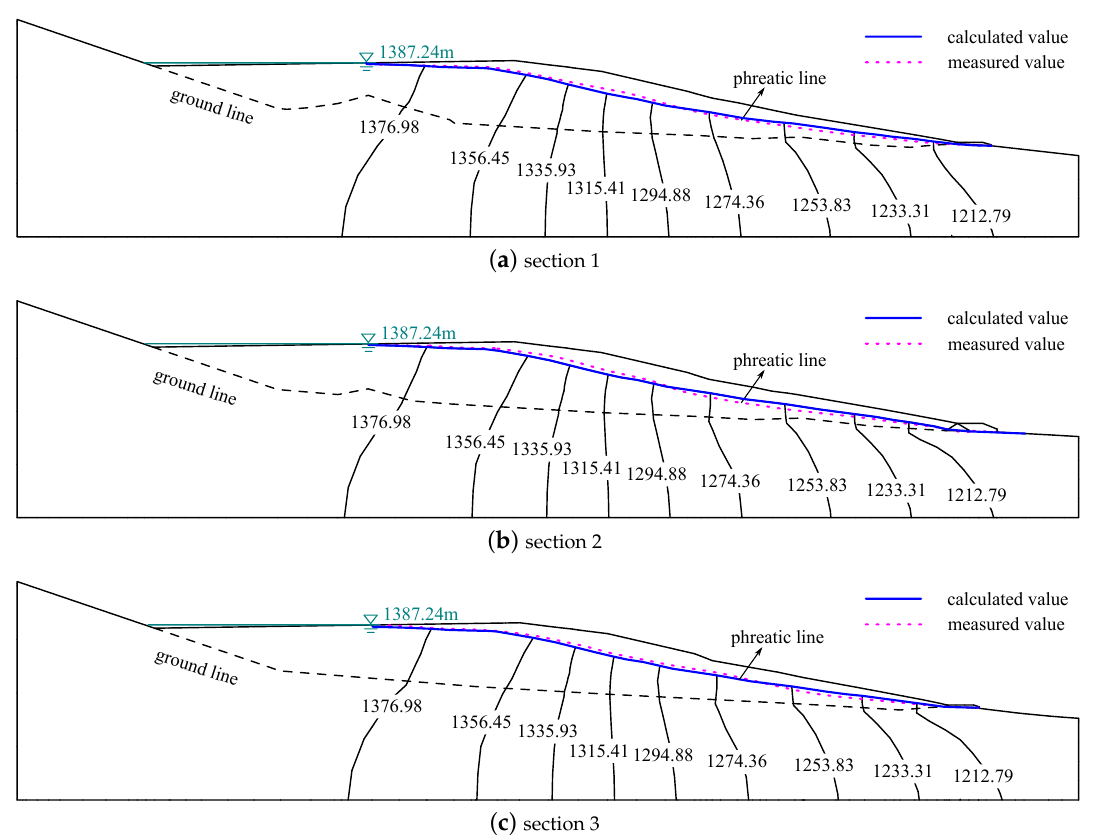
Figure 8. The measured and calculated phreatic lines of different sections (m). These sections are marked in Figure 7. The calculated phreatic line coincides with the measured phreatic